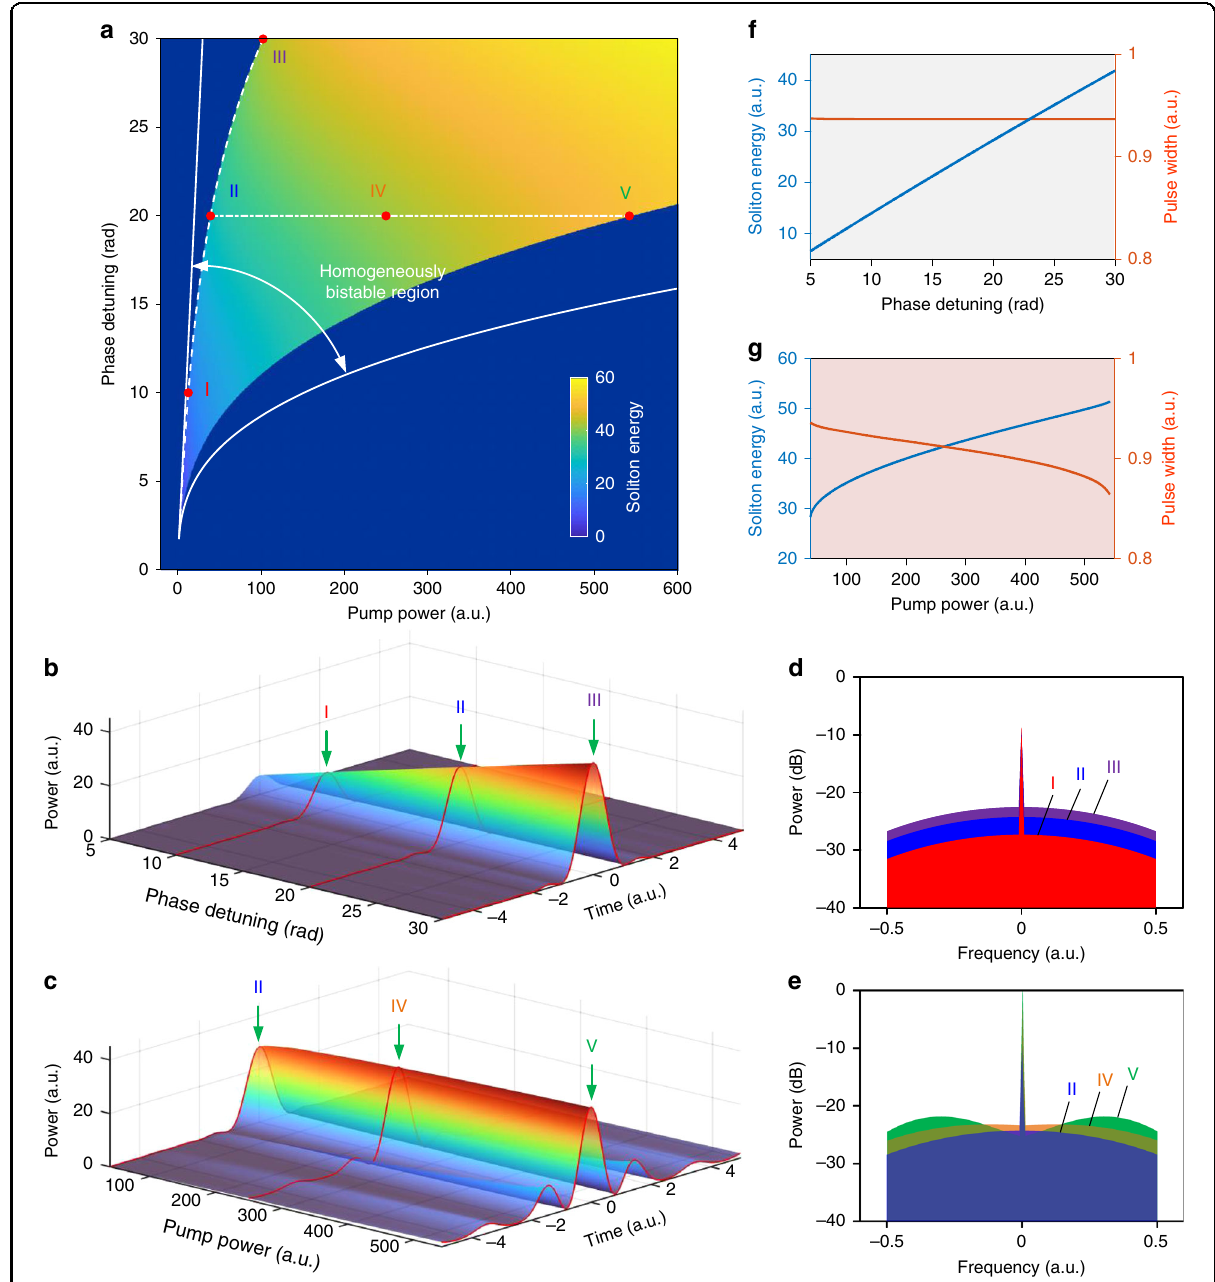
Fig. 4 Evolution of Nyquist solitons. a Soliton existence region. The dispersion-less Nyquist soliton can be maintained in a wide parameter space within the homogenously bistable region. b , c Evolution of the pulse shape along the dash and dash-dotted lines in ( a ) . d , e Soliton spectra at different locations marked in ( a ). For I, II, and III, the pump phase detuning is 10, 20, and 30, respectively. For II, IV, and V, the pump phase detuning is 20 and the pump power is 40, 250, and 540, respectively. f , g Plots of the pulse energy and width along the dash and dash-dotted lines in ( a